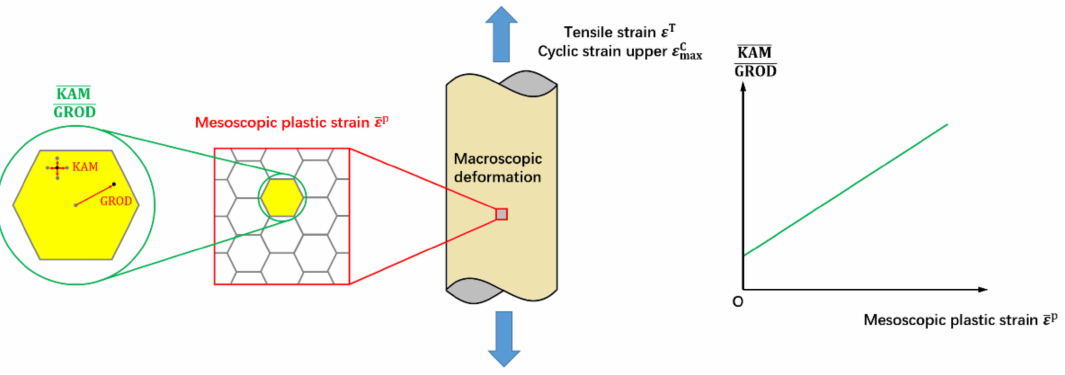
Figure 1. Linear evolution of average KAM and GROD with mesoscopic plastic strain in